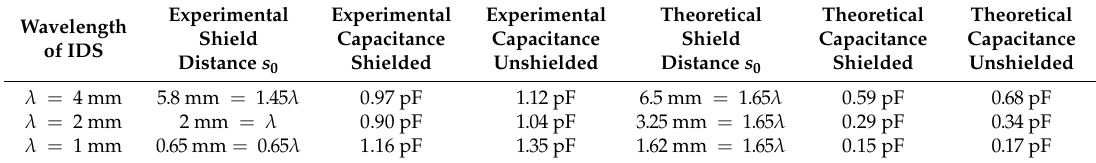
Table 2. Values for the capacitance with shield at s 0 in experiment and theory for all three studied wavelengths. Experimental Experimental Experimental Wavelength Shield Capacitance of IDS Distance s 0 Shielded